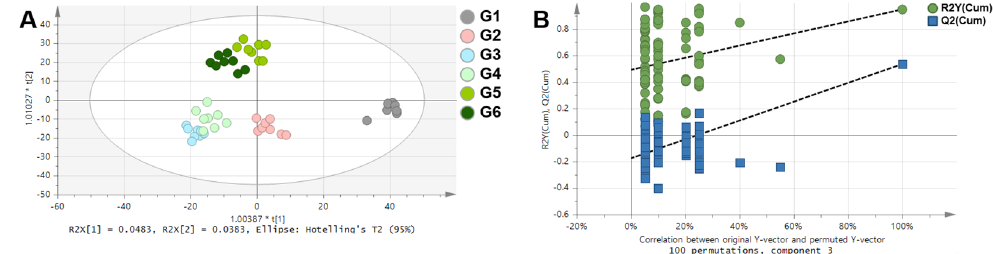
Figure 5. Multivariate statistical analyses of NMR spectra. ( A ) Orthogonal partial least square discriminant analysis (OPLS-DA) score plot of all group comparison (R 2 X = 0.333, R 2 Y = 0.581, Q 2 = 0.175) ( B ) Validation plot of the OPLS-DA model obtained from 100 permutation tests (R 2 Y-intercept = 0.492, Q 2 Y-intercept = − 0.175).